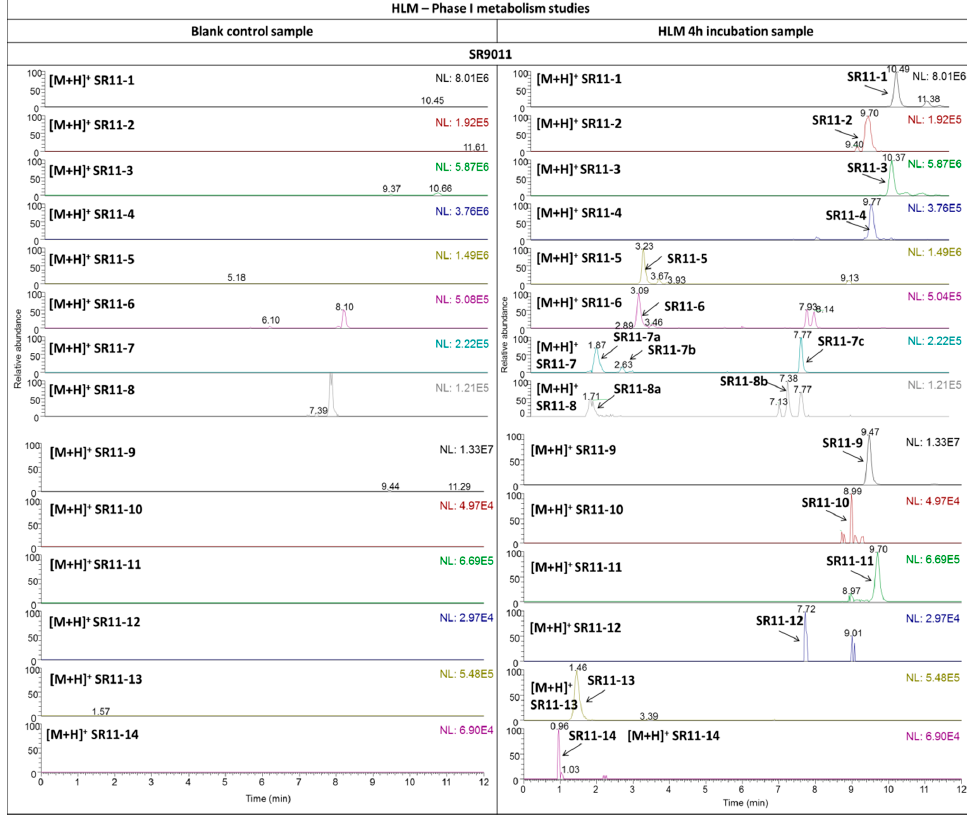
Figure 3. In vitro metabolic studies with SR9011. The extracted ion LC–HRMS chromatograms of the 4-h HLM incubation samples ( right column ) are presented in comparison with blank (without HLM) control samples ( left column ). NL: normalization.